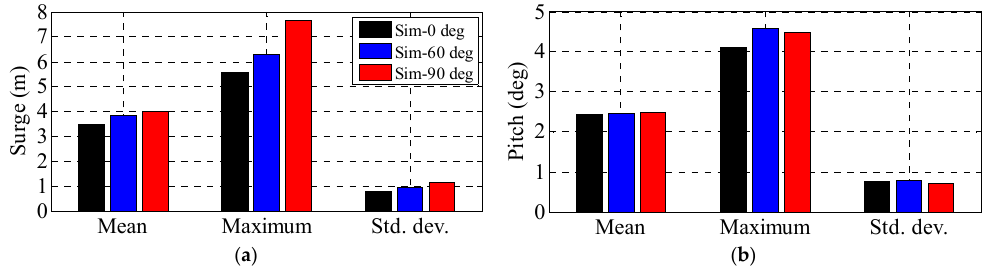
Figure 27. Statistical data of ( a ) surge and ( b ) pitch motion.